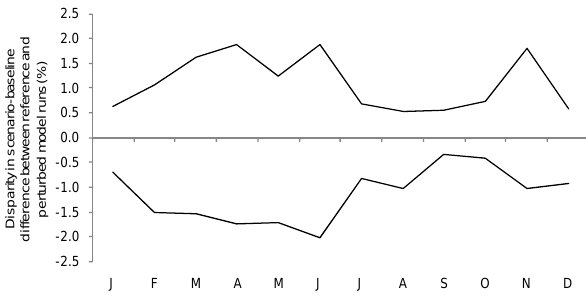
Fig. 7. Model parameter uncertainty for HadCM3 2 ◦ C scenario: maximum extent of the disparity between the scenario-baseline dif- ference in the perturbed parameter versus reference model